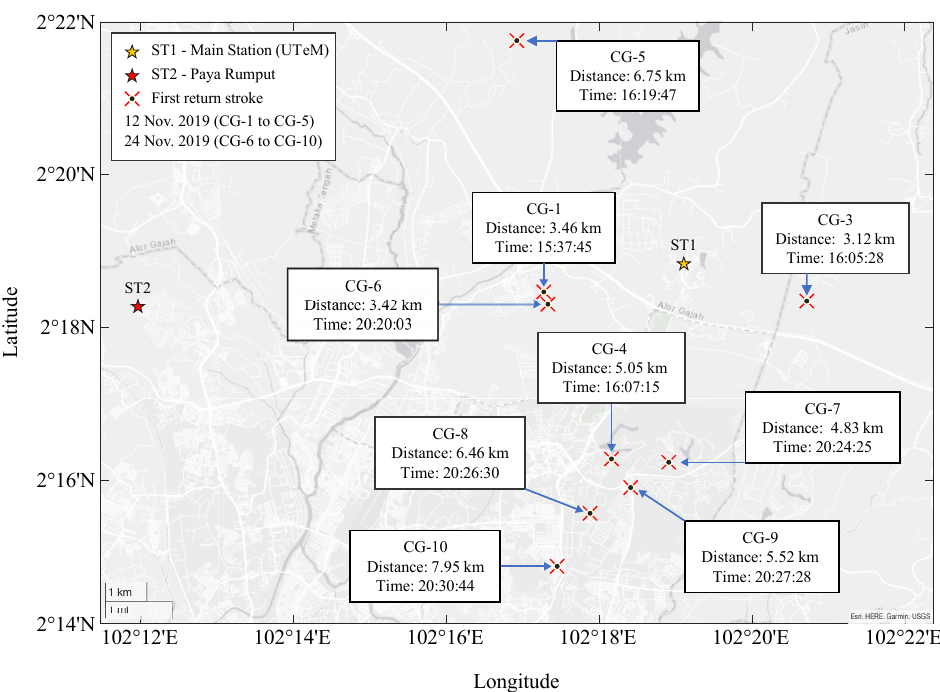
Figure 1. The locations of the first return strokes (RSs, X-mark) from Station 1 (ST1) on 12 and 24 November 2019.